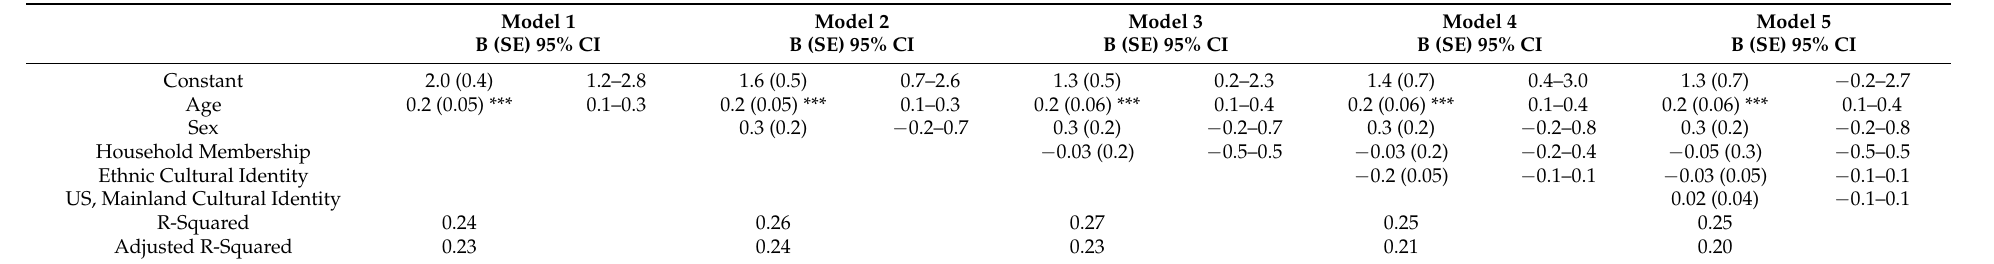
Table 4. Multivariable linear regression examining the association between the number of food groups consumed and selected explanatory variables a in infants 3–12 Months ( n = 70).